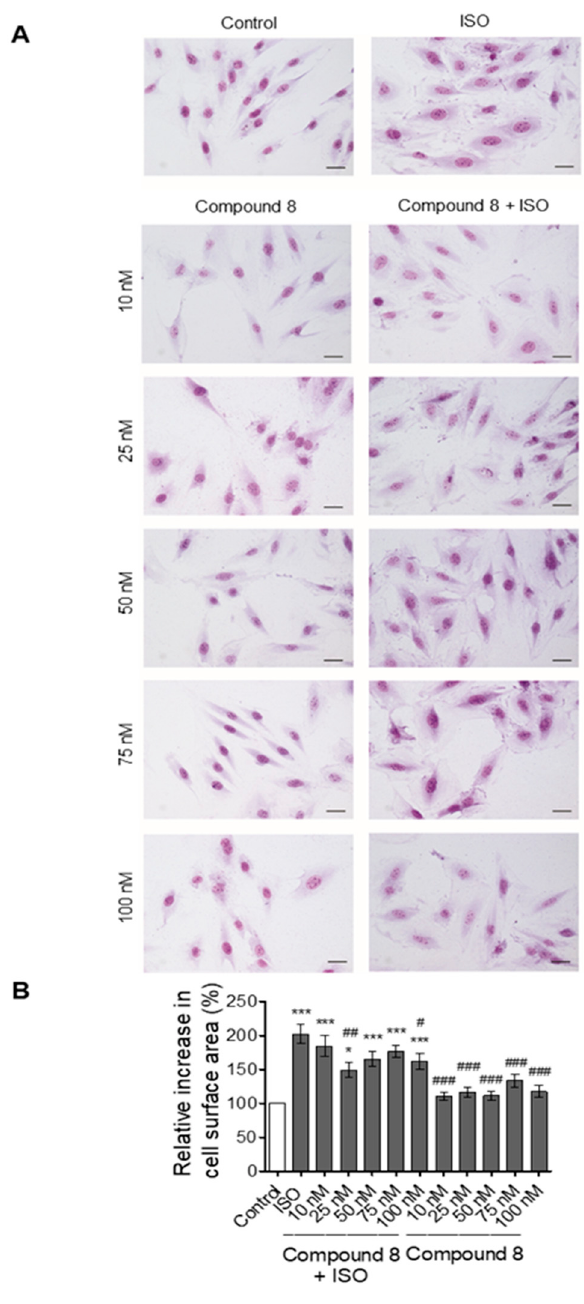
Figure 5. Effects of compound 8 on cardiomyocytes hypertrophy induced by isoproterenol (ISO) in vitro. (A) Morphological staining of H9c2 cells exposed to vehicle (indicated as Control), ISO (100 μ M), ISO + compound 8 (from 10 nM to 100 nM) and compound 8 (from 10 nM to 100 nM) for 24 h. Scale bars: 25 μ m. ( B ) Cell surface area (%) of H9c2 cells exposed to vehicle (indicated as Control), ISO (100 μ M), ISO + compound 8 (from 10 nM to 100 nM) and compound 8 (from 10 nM to 100 nM) for 24 h. Data are expressed as mean ± SEM derived from two independent measurements for each group. p < 0.05 (*); p < 0.001 (***) vs. Control group; p < 0.05 (#); p < 0.01 (##); p < 0.001 (###) vs. ISO group (one-way ANOVA and Newman-Keuls multiple comparison